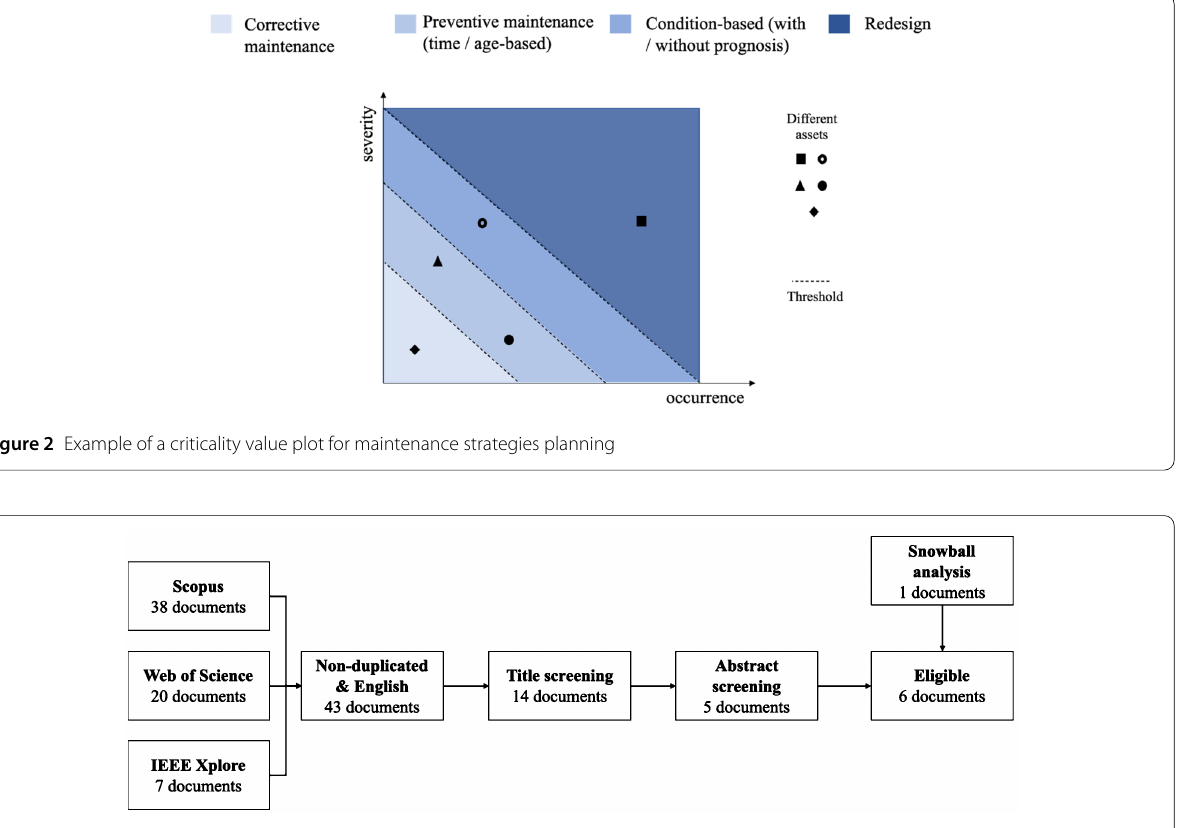
Figure 3 Overview of the research